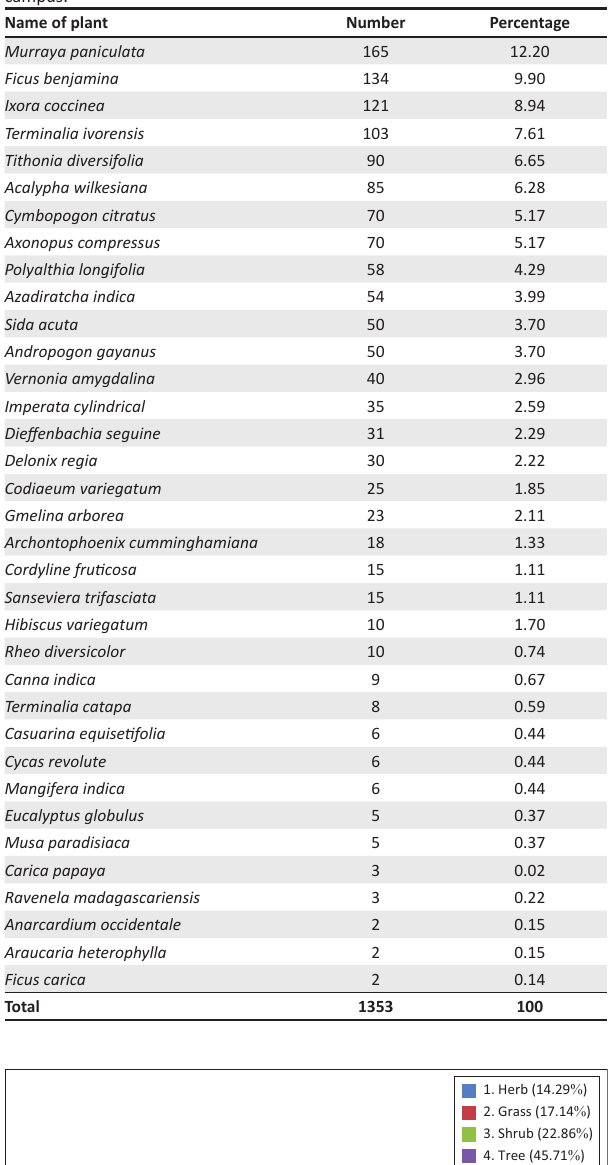
TABLE 3: Species distribution within the identified families. Families